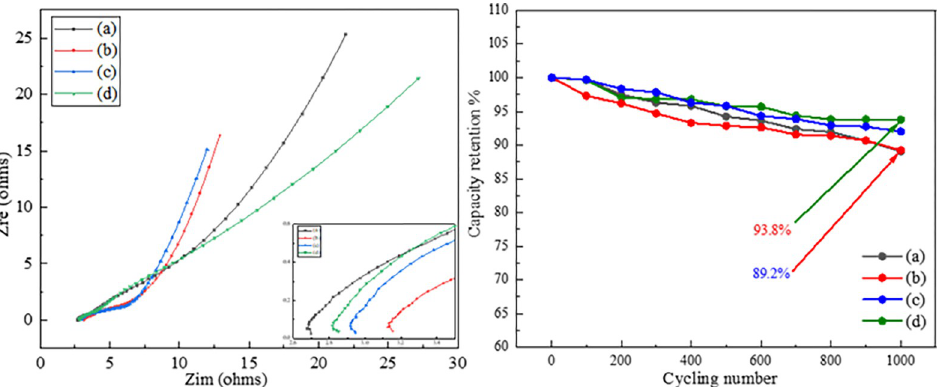
Fig 8. The Nyquist plots of the EIS of various electrode materials (left) and the cycling durability of various electrodes for 1000 cycles at 50 mV s-1 (right), wherein (a) product M (b) product MC (c) product MCD and (d) product MCE.